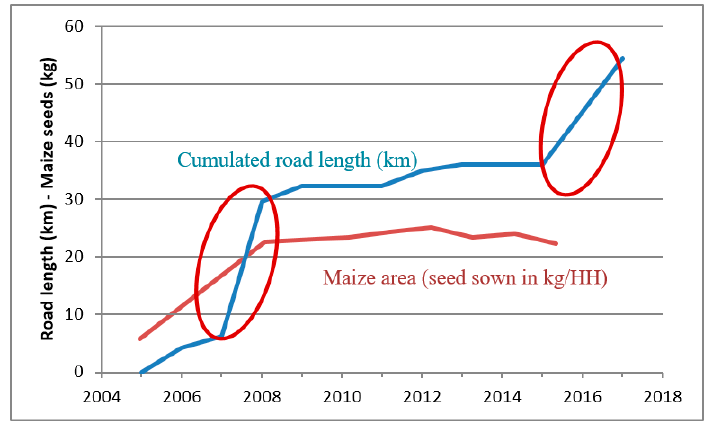
Figure 9. Cumulative length of feeder roads and expansion of maize areas.